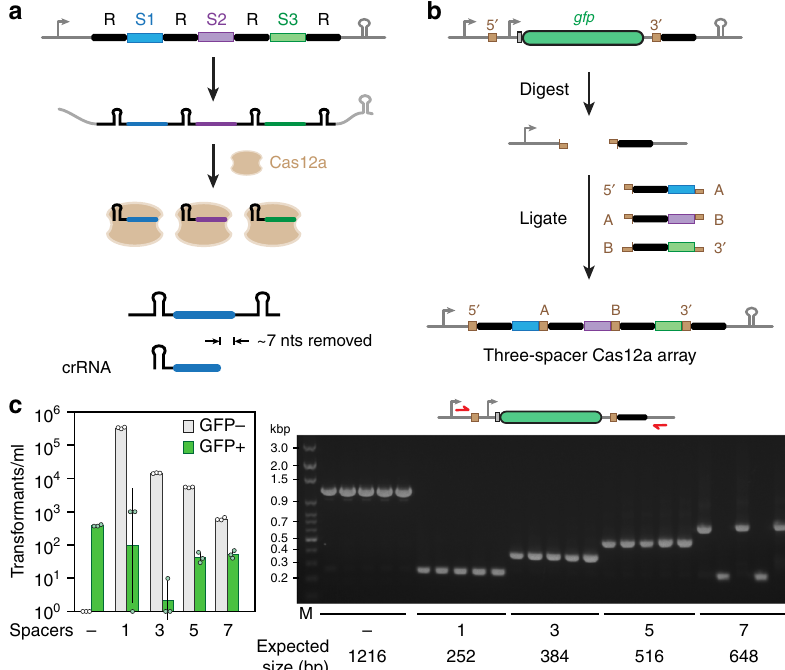
Fig. 1 A modular, one-pot assembly scheme for CRISPR-Cas12a arrays based on spacer trimming. a Processing of the transcribed CRISPR array by the Cas12a nuclease. Each array comprises alternating repeats (R, black bars) and spacers (S1 – S3, colored bars). Processing includes 3 ′ trimming of the spacer to form the fi nal crRNA. b Cloning scheme for the assembly of multi-spacer arrays recognized by Cas12a. A GFP-dropout construct is fl anked by two Type IIS restriction sites and a 3 ′ direct repeat. The digested construct is ligated with annealed oligonucleotides encoding individual repeat-spacers in one step. The 3 ′ repeat is located in the backbone plasmid so the insertion of repeat-spacer subunits results in an array that begins and ends with a repeat. The sequence and 5 ′ or 3 ′ directionality of the junction overhangs determine the order of assembly. The resulting assembly junctions fall within the trimmed portion of the processed guide RNA and therefore would not be involved in target recognition. c Ef fi cient assembly of up to a seven-spacer array. Assembly ef fi ciency was based on the relative proportion of fl uorescent or non- fl uorescent E. coli colonies (left) and the correct insert size of non- fl uorescent colonies subjected to colony PCR (right). Values represent the geometric mean and S.D. from three independent transformations starting from separate colonies. See Supplementary Table 3 for the speci fi c sequences used. The dash represents the original GFP-dropout construct. Source data are provided as a